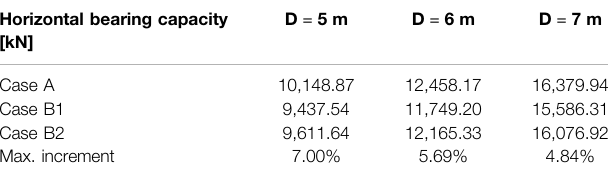
TABLE 4 | The horizontal bearing capacity of the monopile for different